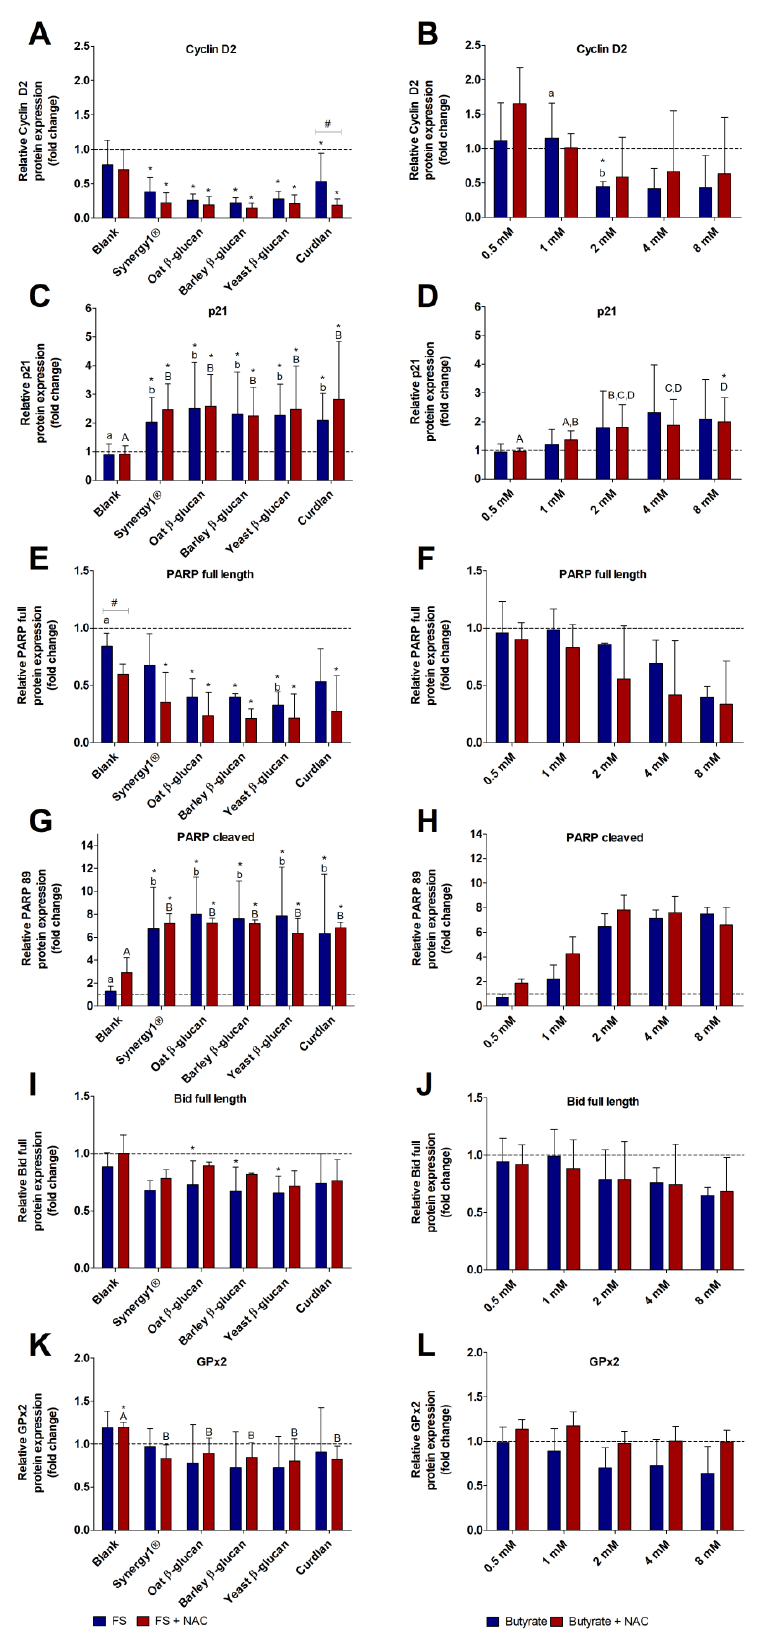
Figure 4. Relative protein expression of Cyclin D2 ( A , B ), p21 ( C , D ), full-length PARP ( E , F ), cleaved PARP (89 kDa) ( G , H ), full-length Bid ( I , J ), and GPx2 ( K , L ) in LT97 cells after treatment with FS